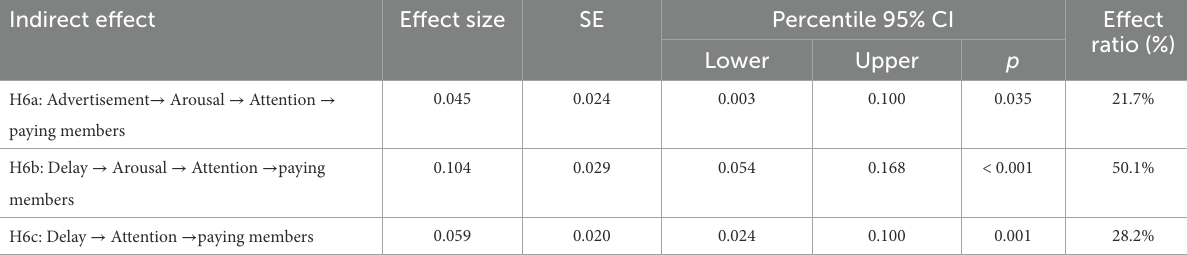
TABLE 5 Bootstrapping test for mediating effects.